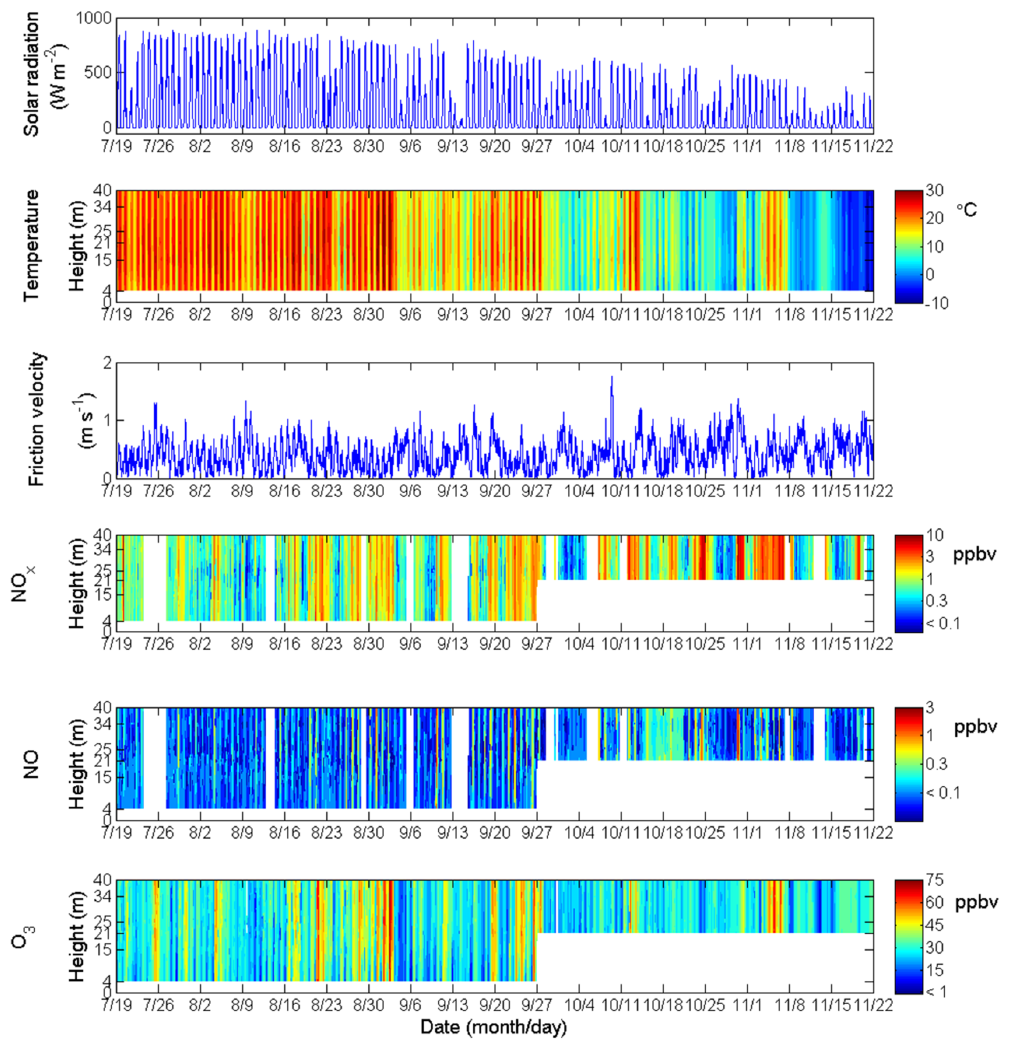
Fig. 2. The evolution of solar radiation, temperature profile, friction velocity, and the mixing ratio profiles of NO x , NO , and O 3 at the UMBS AmeriFlux site from 19 July to 21 November 2008. Missing data were due to taking the instruments offline for calibrations and repairs and due to running intercomparison tests of the sampling inlets. Gaps in the chemical data below the canopy from 27 September onward were due to failures in the 4 and 15 m switching valves.